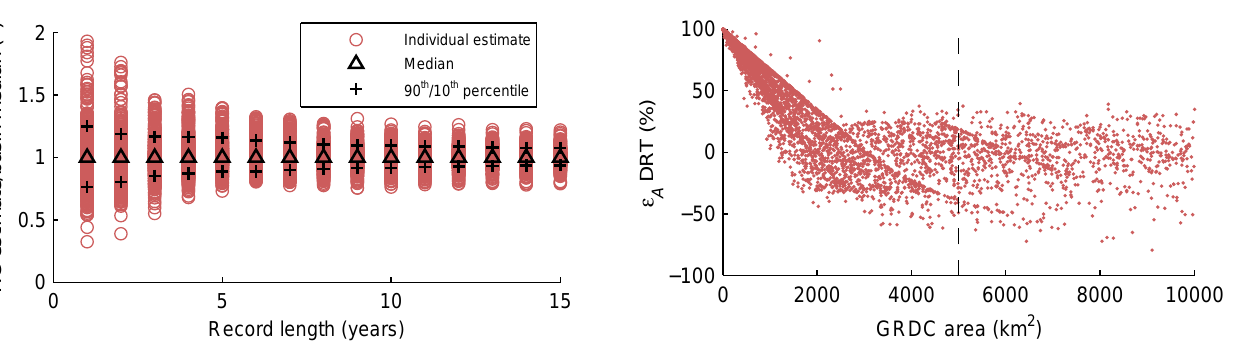
Fig. 3. Relative area difference after automatic relocation for all 7518 GRDC stations with sufficient metadata. The dashed line in- dicates the 5000km 2 threshold used to select the basins for the rest of the analyses in the